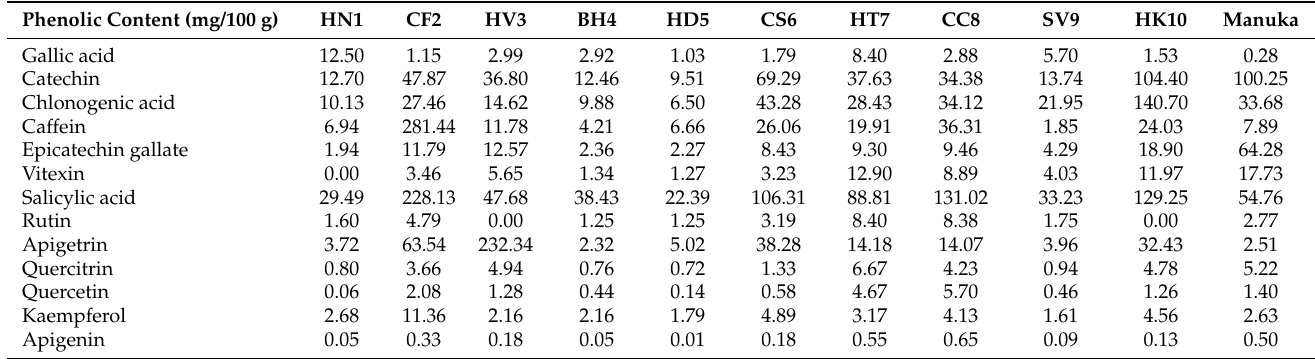
Table 7. Phenolic content of honey samples.